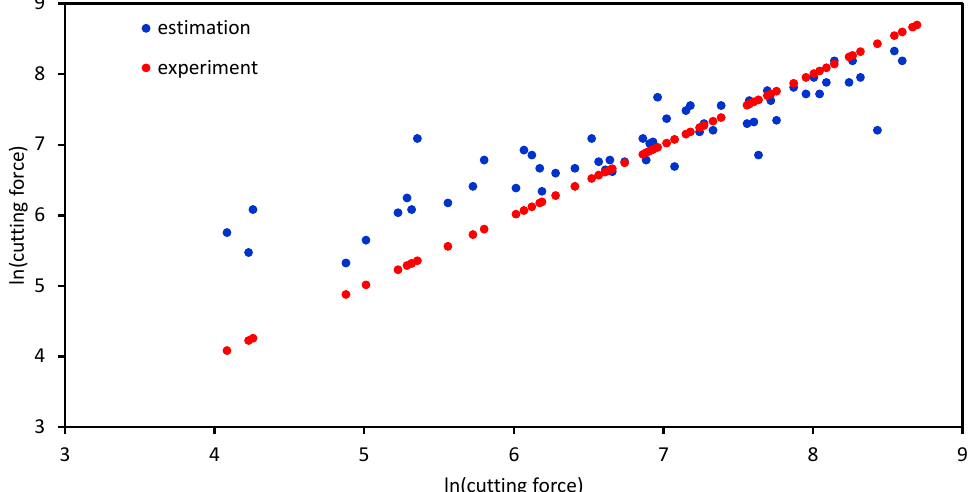
Figure 3. Scatter plot of experimental and estimated values by K-fold cross validation during training of the deep learning